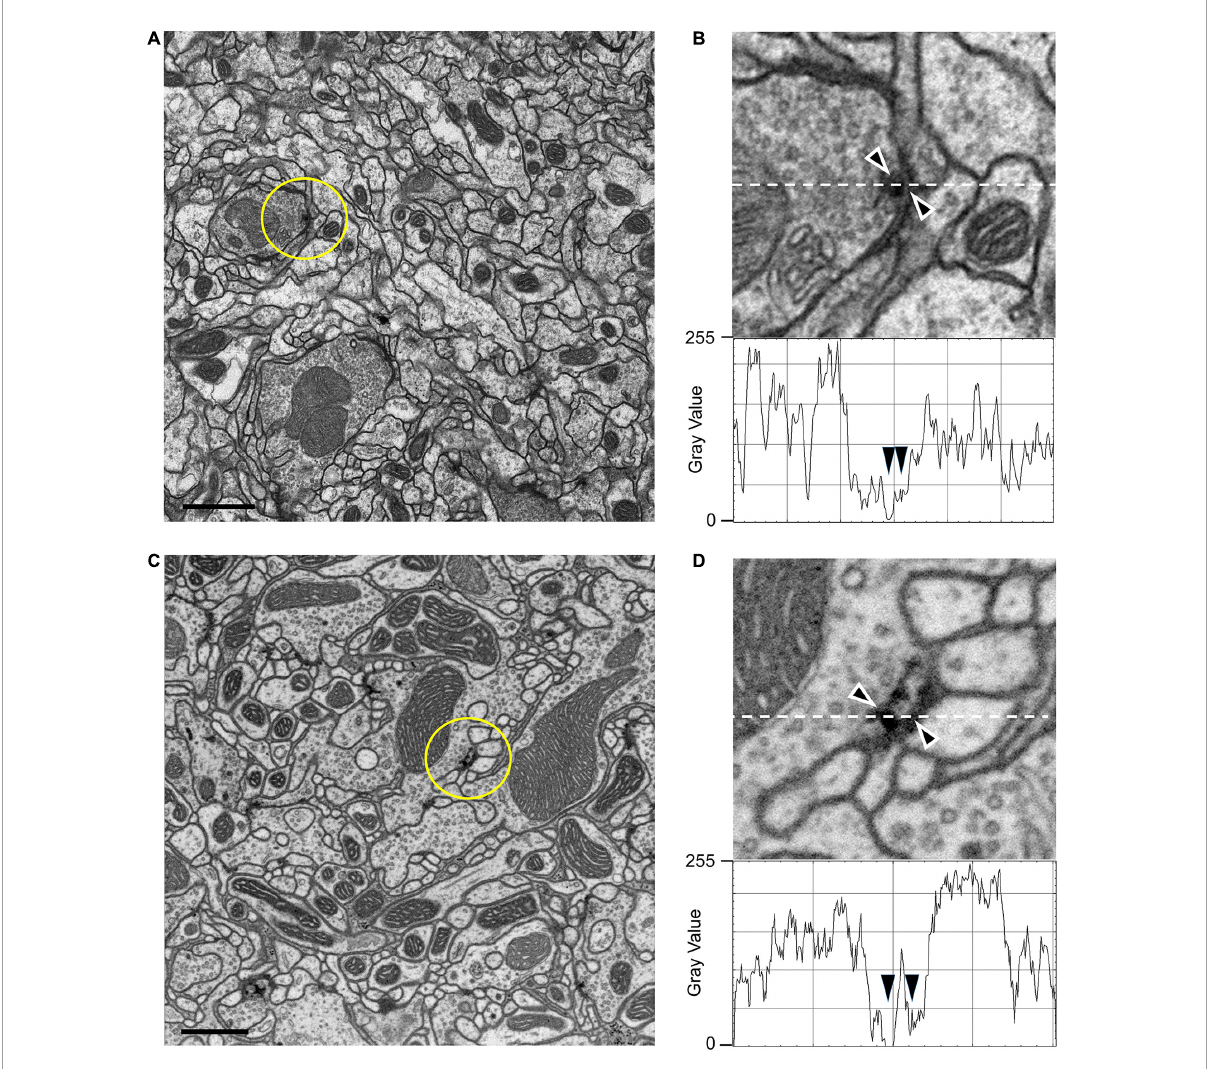
FIGURE2 TEM (A,B) and FIB-SEM (C,D) images compared. (A) TEM image from series of 50-nm sections post-stained from the mushroom body calyx reported in Butcher et al. (2012); image resolution is 3.7 nm per pixel. (B) Enlargement from (A) to show the ultrastructure of a synapse and membranes. Image is scanned in the lower panel to show the gray-scale values for staining, especially for the synapse and synaptic membranes (arrowheads). (C) Compare image quality with high-resolution 4-nm per pixel FIB-SEM image of the protocerebral bridge (see also Supplementary Video 2 ). (D) Representative individual synaptic profile and synaptic membranes from (C) are indicated by arrowheads in (D) , pointed to the T-bar presynaptic ribbon and synaptic membranes. The image is scanned along the interrupted white line to show the gray scale value through organelles. Arrowheads for scan line indicate the electron density of the selected synapse and its membranes. Note that the contrasts of the synaptic T-bar and membrane density in the FIB-SEM image (D) both match those from TEM (B) . Scale bars (A,C) 1 µ